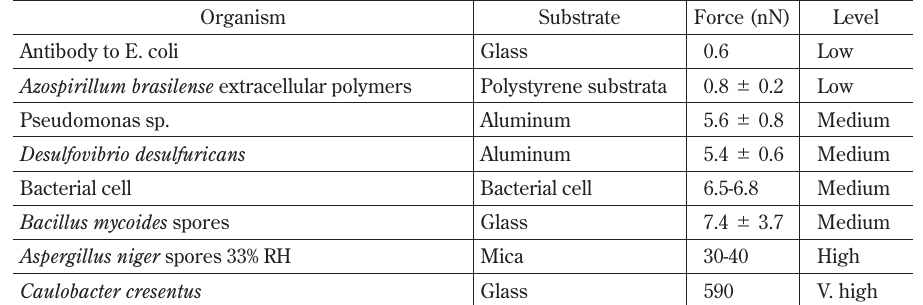
Fig. 5 Virtual impactor designed for a biological detector based on immunological measurements using specific antibody preparations. a. external view showing an attachment to facilitate flow rate measurements, b anemometer probe above the first concentrator stage, c view of first concentrator surface after processing a biological aerosol and d similar view of the second concentrator stage. Part of the surfaces in c & d were wiped clean to provide refractive contrast. Note significant built up of particulate dust on the internal surfaces. Table 1 Typical adhesion forces measured by atomic force microscopy, values taken from a number of open literature